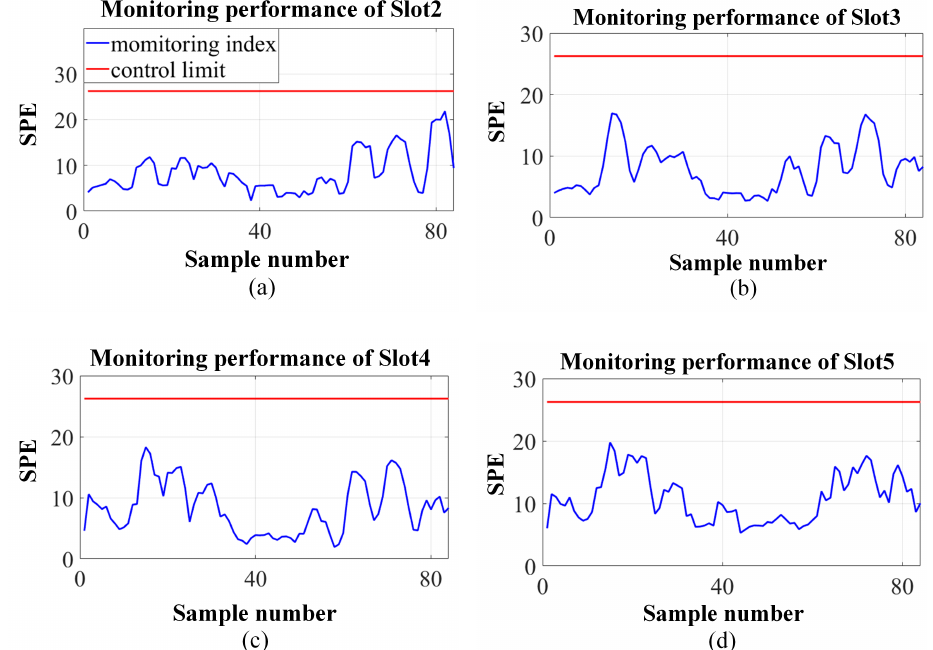
Figure 6. Monitoring results of AL-90. ( a – d ) is the performance of SPE of SiSAE on slot 2,3,4, and 5, respectively.